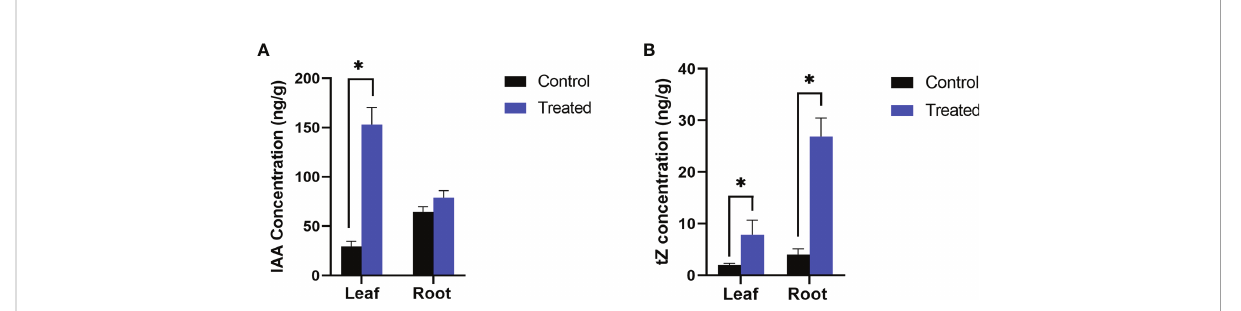
FIGURE 2 Endogenous level of growth hormones, (A) IAA and (B) Trans zeatin (tZ) in P. indica colonized and non-colonized plants. Samples are taken 60 th DAI. Hormone quanti fi cation was carried out on the basis of peak area ratio with the hormone standards using LC/MS. Each value is the mean ± SE of three biological replicates. Asterisks indicate signi fi cance at * P < 0.05 by student t - test.